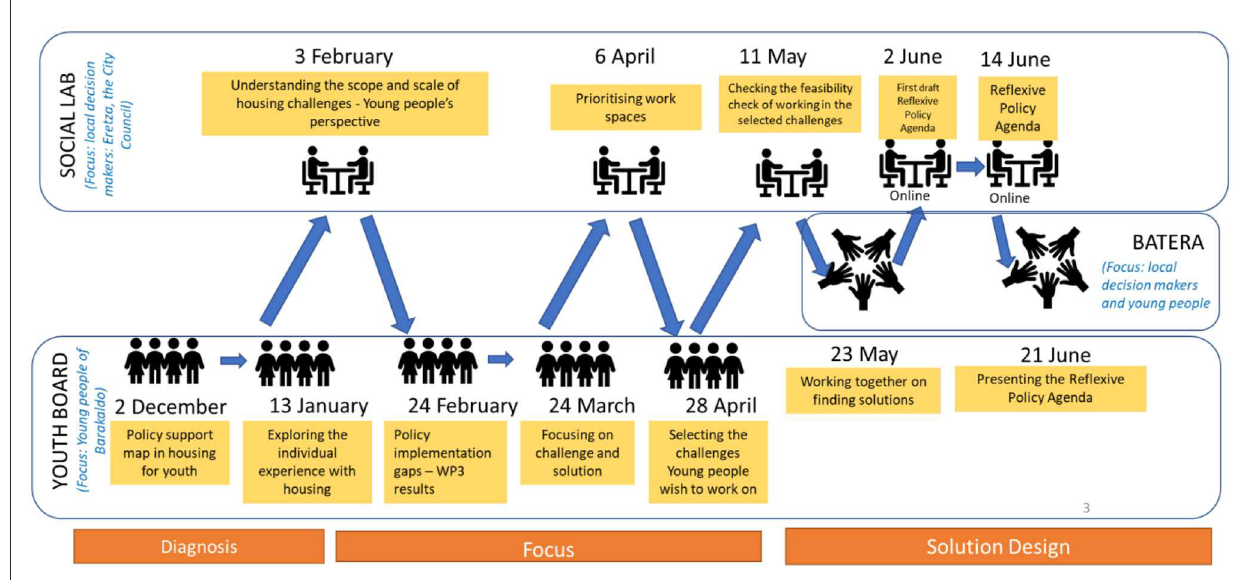
FIGURE1 The co-creation process for a Reflexive Policy Agenda (RPA) in Barakaldo. Source: Own elaboration.